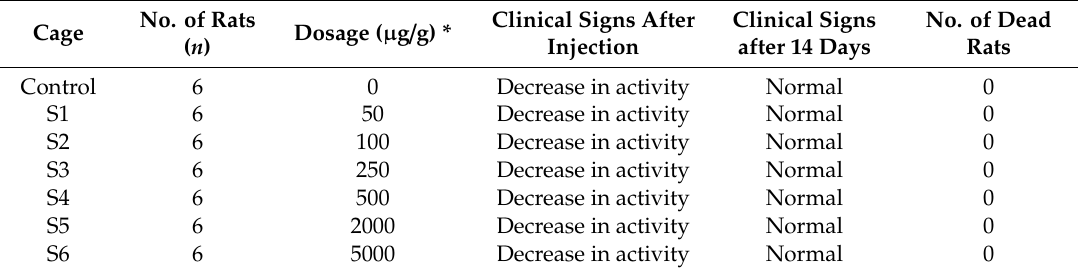
Table 5. The LD 50 study of compound 6a